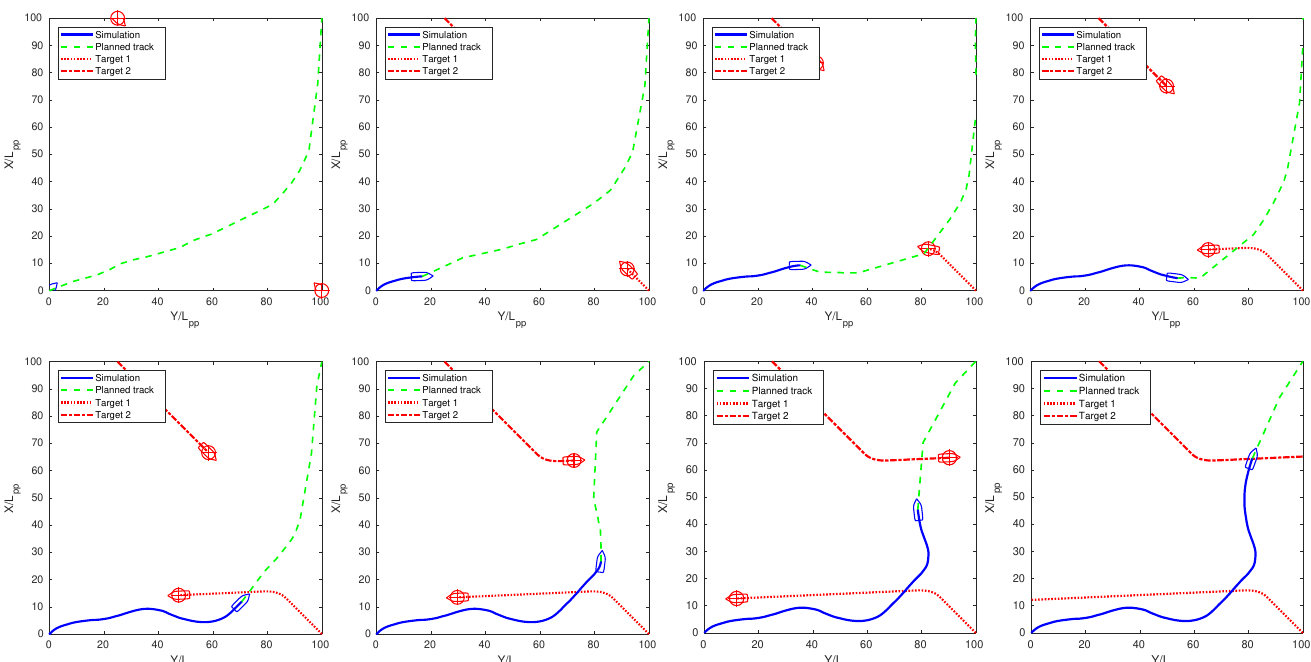
Figure 9. Scenario 1: simulation of a COLREG-compliant manoeuvre with unexpected target behaviour.